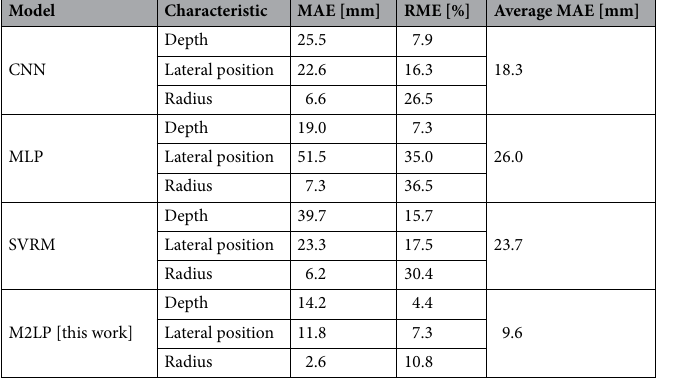
Table 5. Breakdown of the best prediction performance of the proposed and the benchmark models, over ten independent runs. The models trained using the dataset DS4 (500 samples).